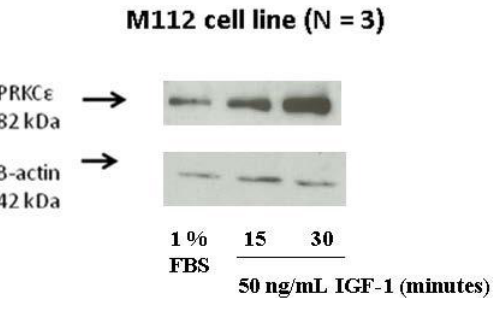
Figure 10. Protein expression of PRKCε is induced by IGF-1 treatment. Western